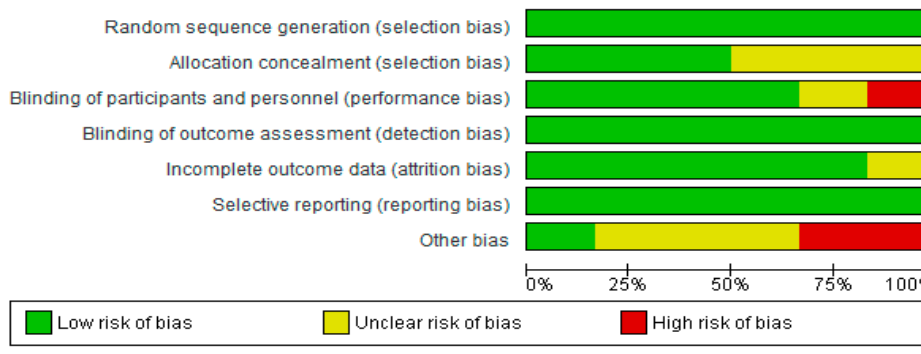
Figure 6. Risk of bias graph of CT: review authors’ judgments about each item as percentages across all included